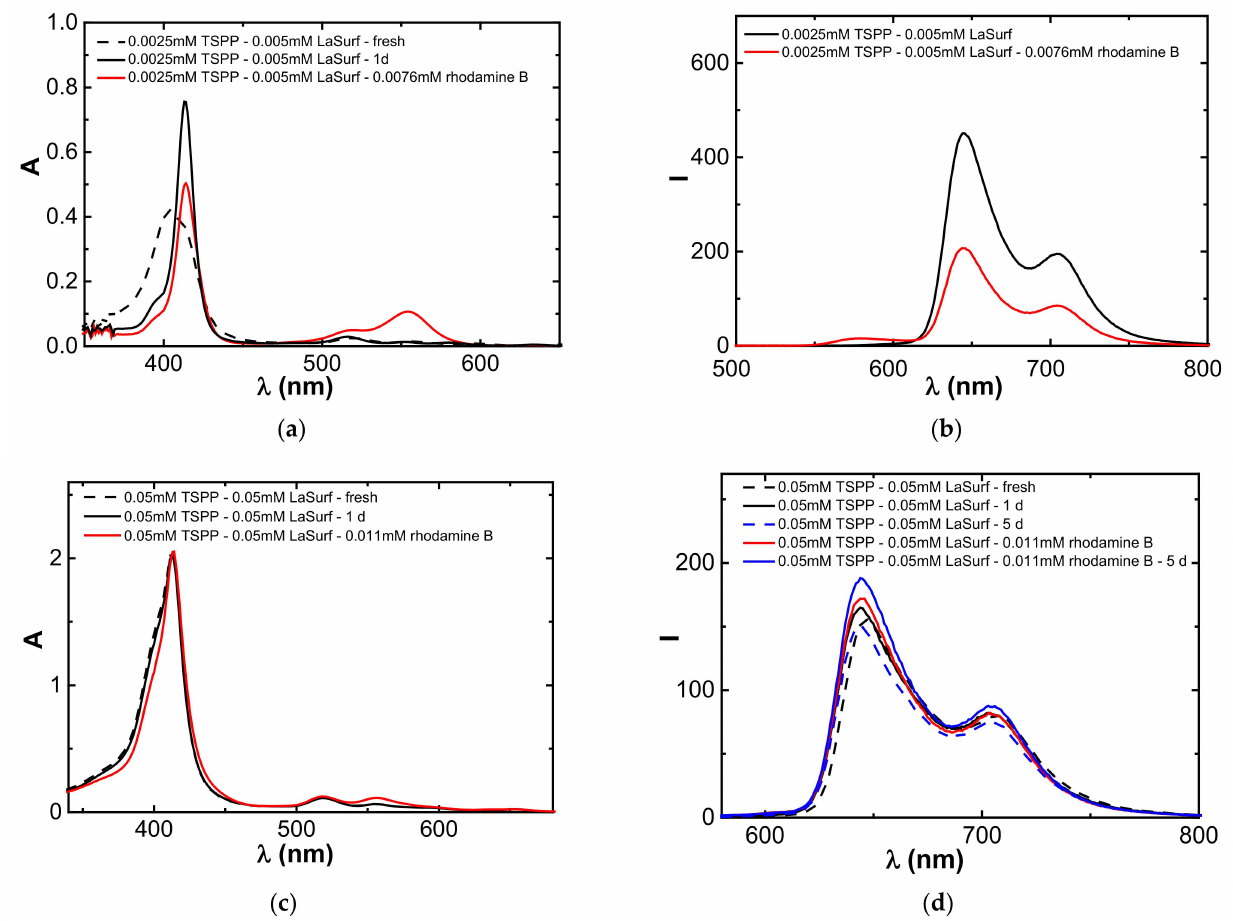
Figure 9. UV (path lengths of 10 mm ( a ) and 2 mm ( c )) and fluorescence spectra ( b , d ) for TSPP:LaSurf = 1:2 and 1:1 systems with encapsulated rhodamine